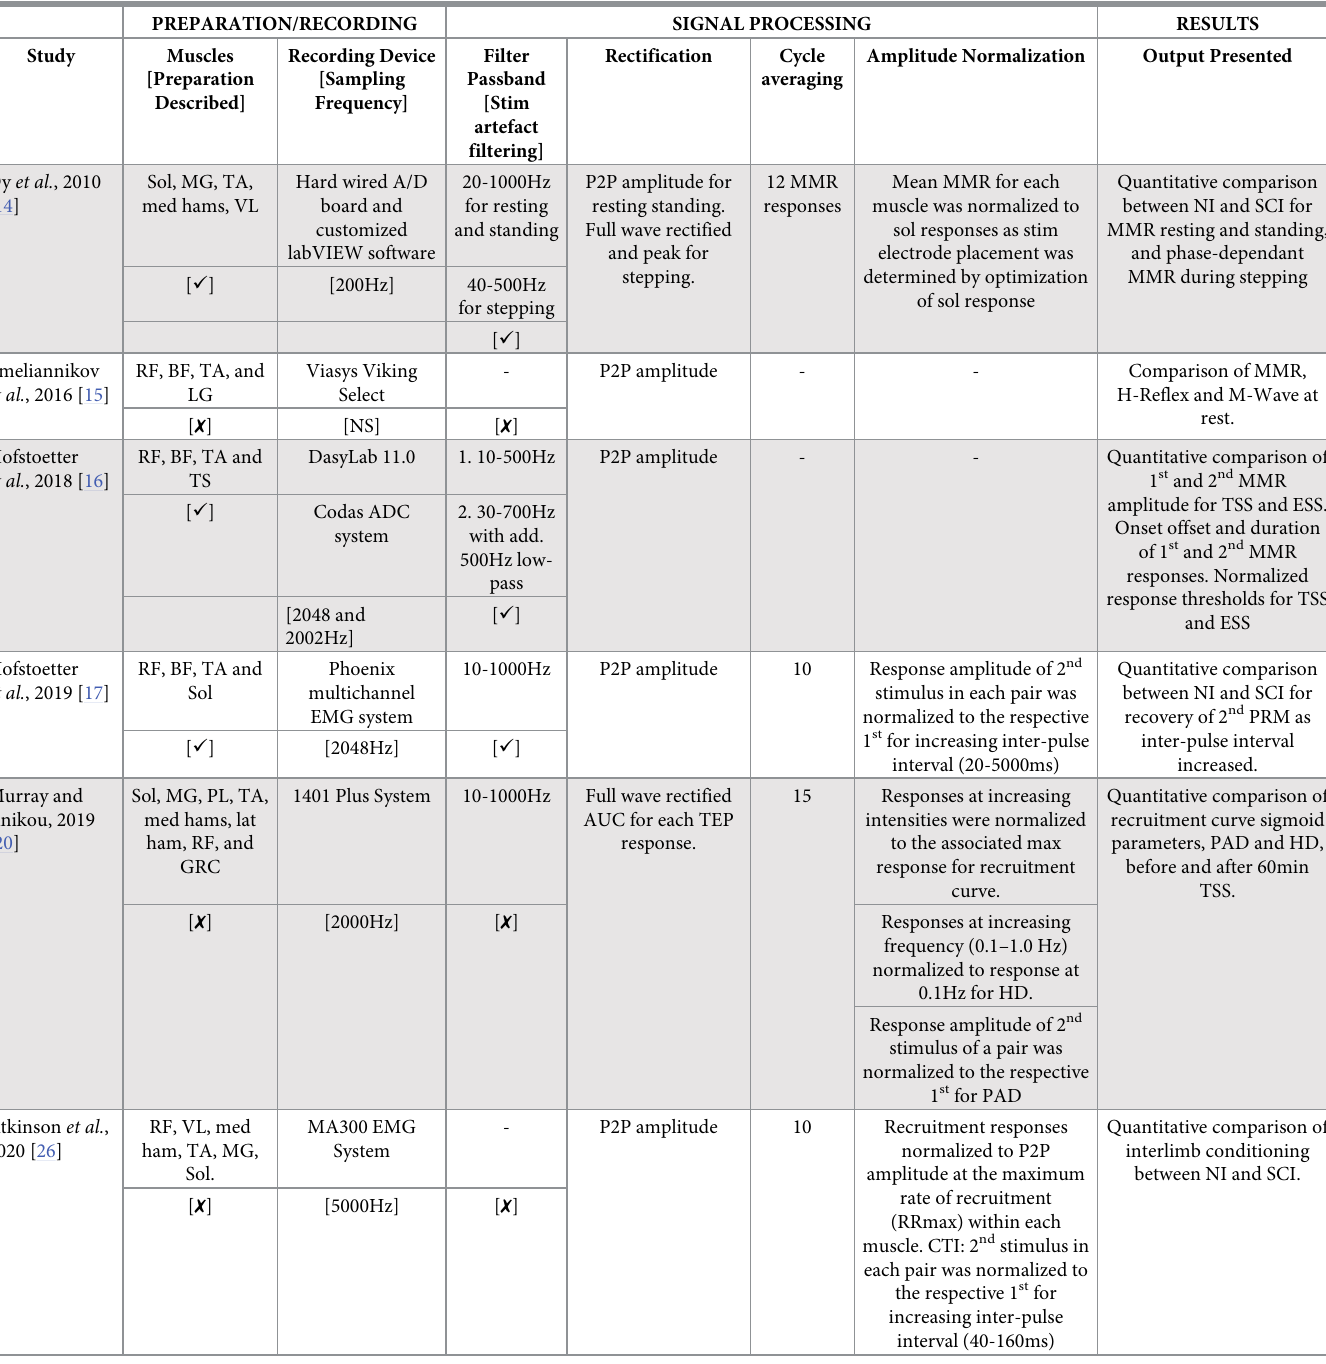
Table 9. A summary of evoked surface EMG data collection, recording and signal processing. EMG recording and signal processing for studies carrying out neuro- physiological